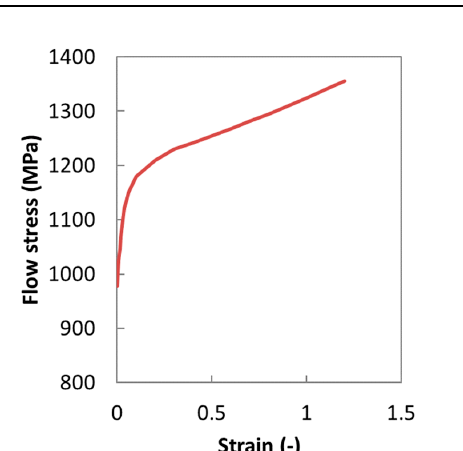
Figure 15. Flow stress plot.